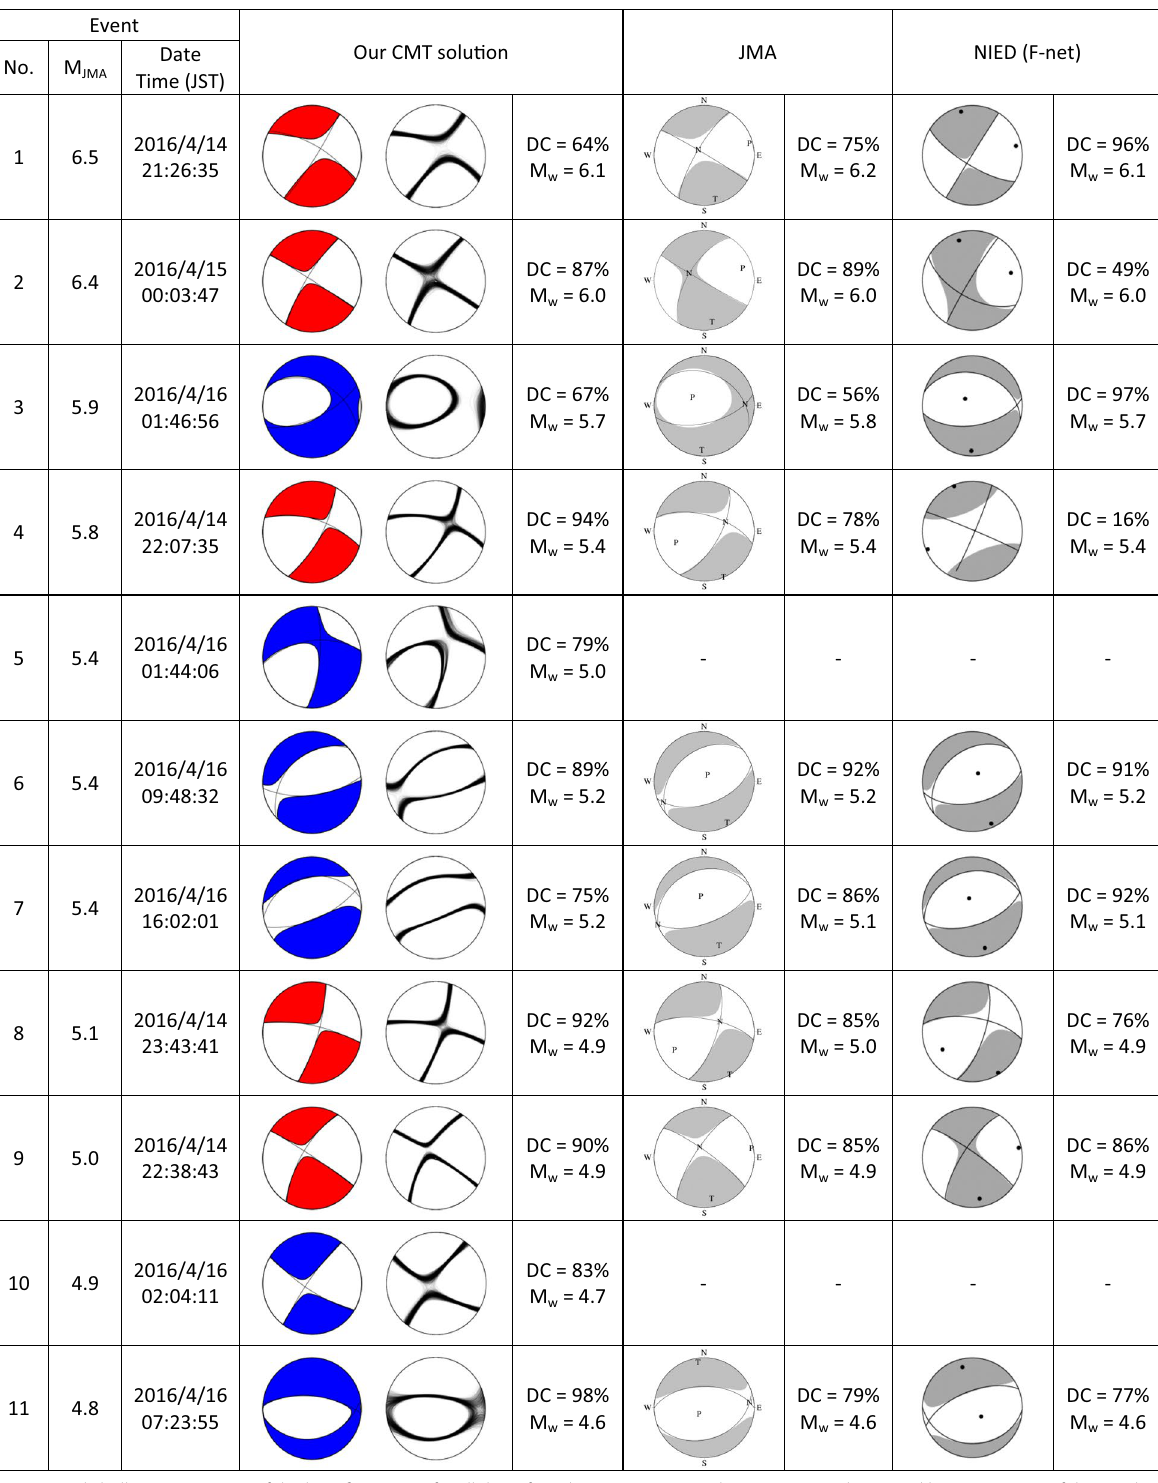
Fig. 6 Beach-ball representation of the best fitting MTs for all the inferred events. Our MT solutions are supplemented by uncertainty of the mecha- nism depicted by 1000 random possible solutions drawn from the ten-dimensional posterior PDF. JMA and NIED solutions are adopted directly from the routine MT catalogues of these agencies accessed through